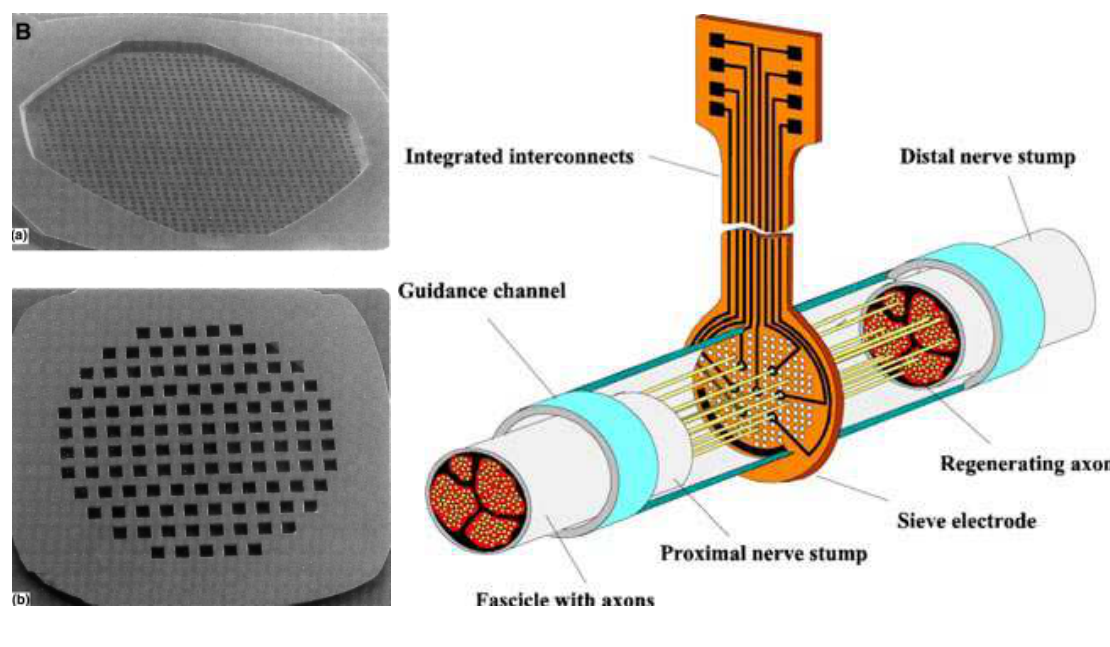
Figure 8. Microfabricated sieve electrodes (a &b) and a schematic of their placement in the guidance channel [173,